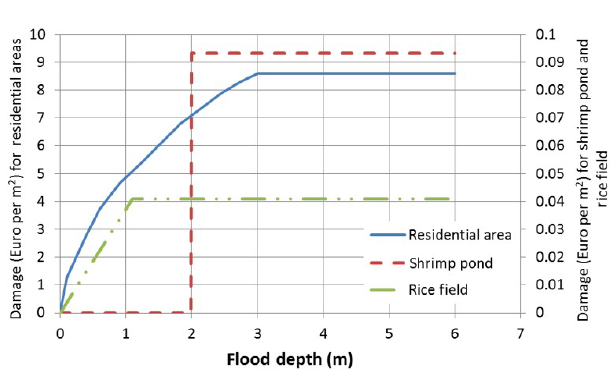
Figure 7. Depth–damage curves for different land use